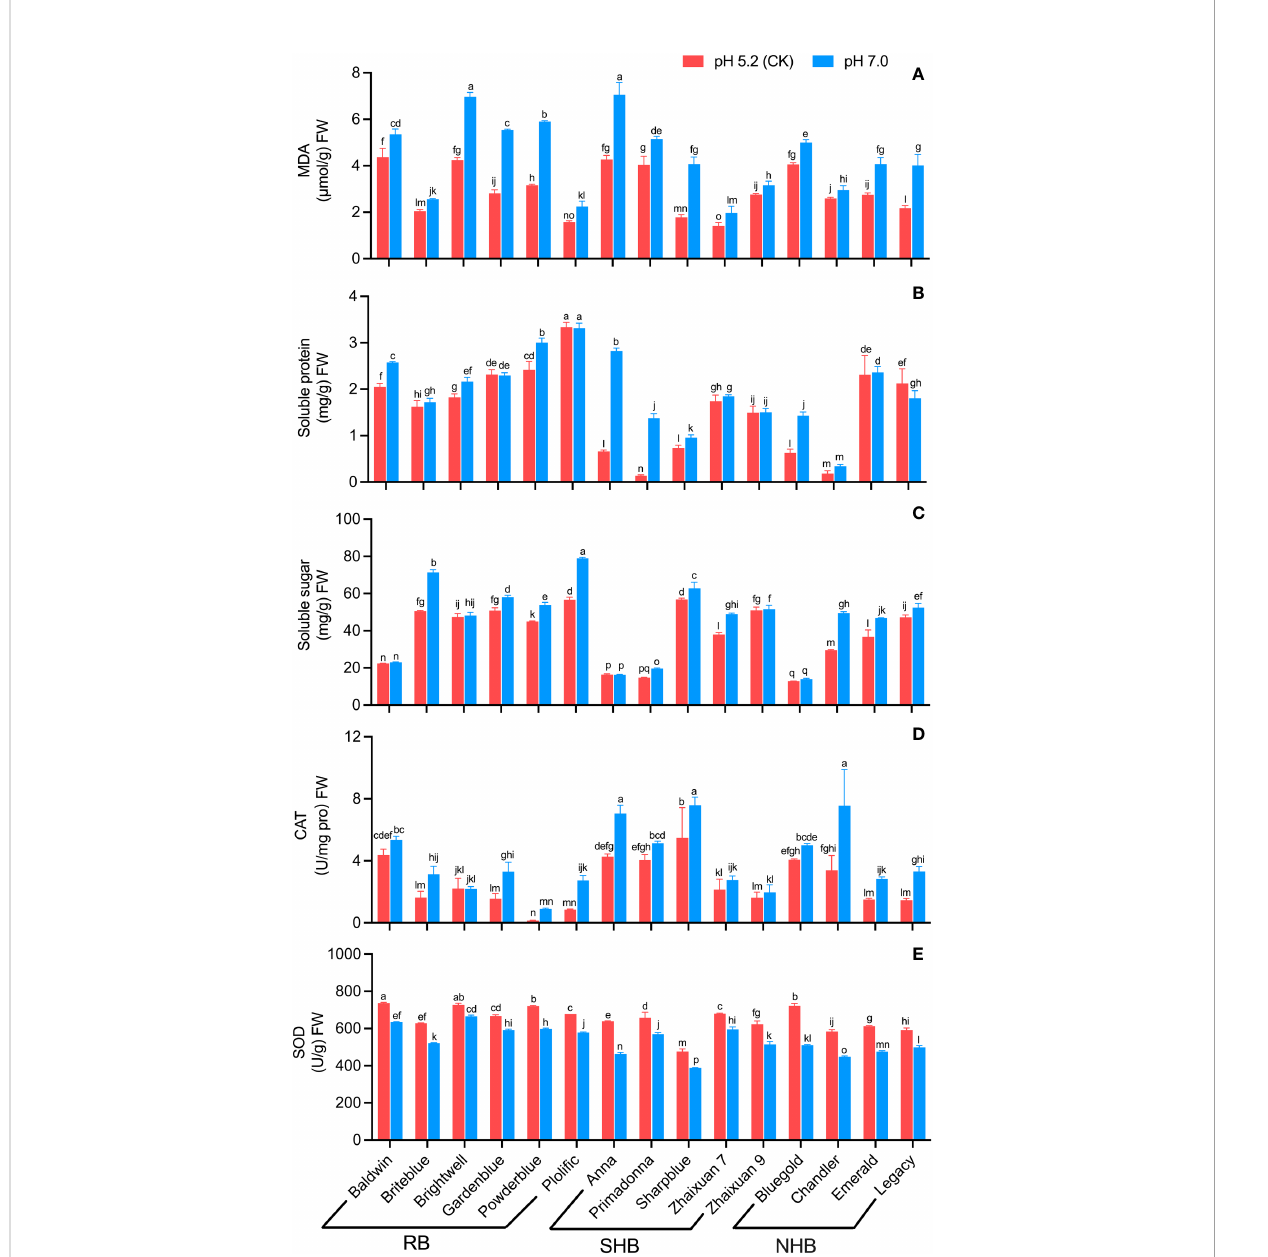
FIGURE 4 Effects of high soil pH stress on the leaf physiological characteristics of 15 blueberry seedling cultivars. The content of MDA (A) , soluble protein (B) , and soluble sugar (C) , the enzyme activity of CAT (D) and SOD (E) . Columns with different letters signi fi cantly (p < 0.05) differed based on Duncan ’ s multiple range